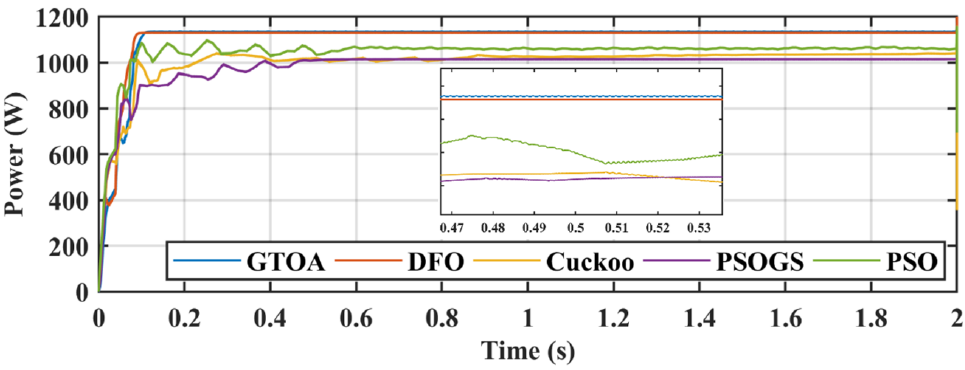
Figure 28. Zoomed-in comparison of power of GTOA.